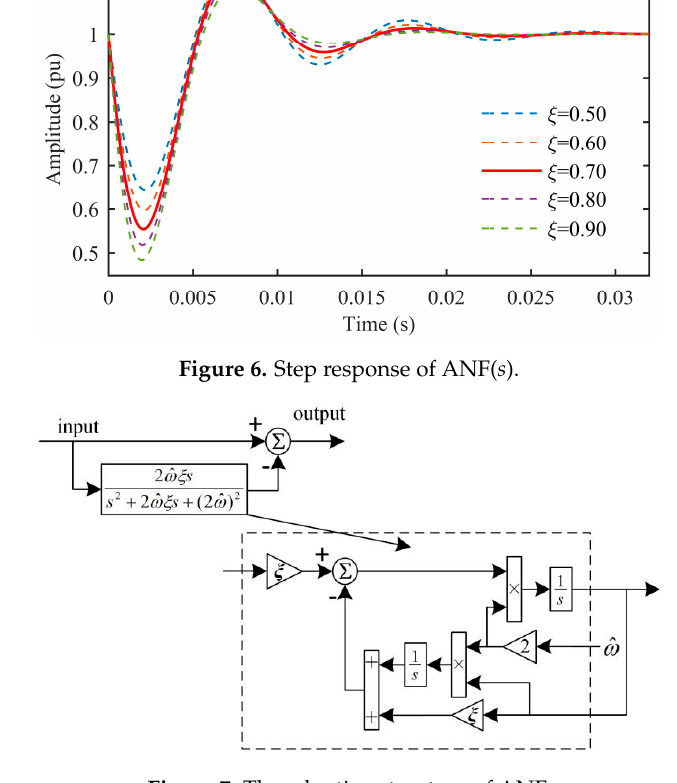
Figure 7. The adaptive structure of ANF.